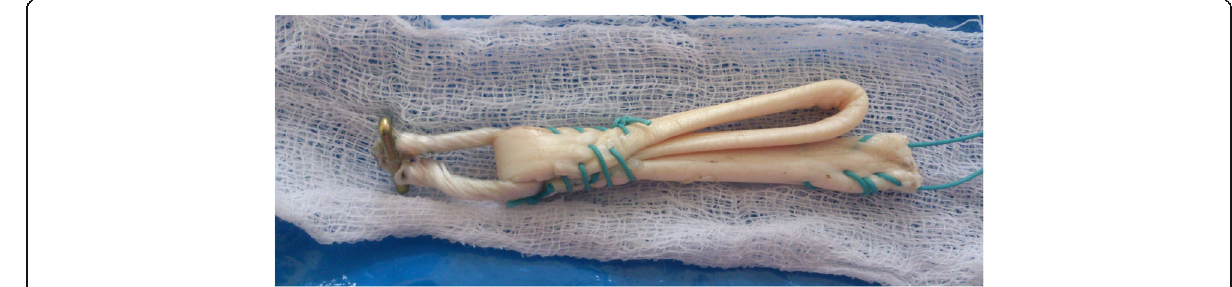
Fig. 3 Tripled graft configuration in Group